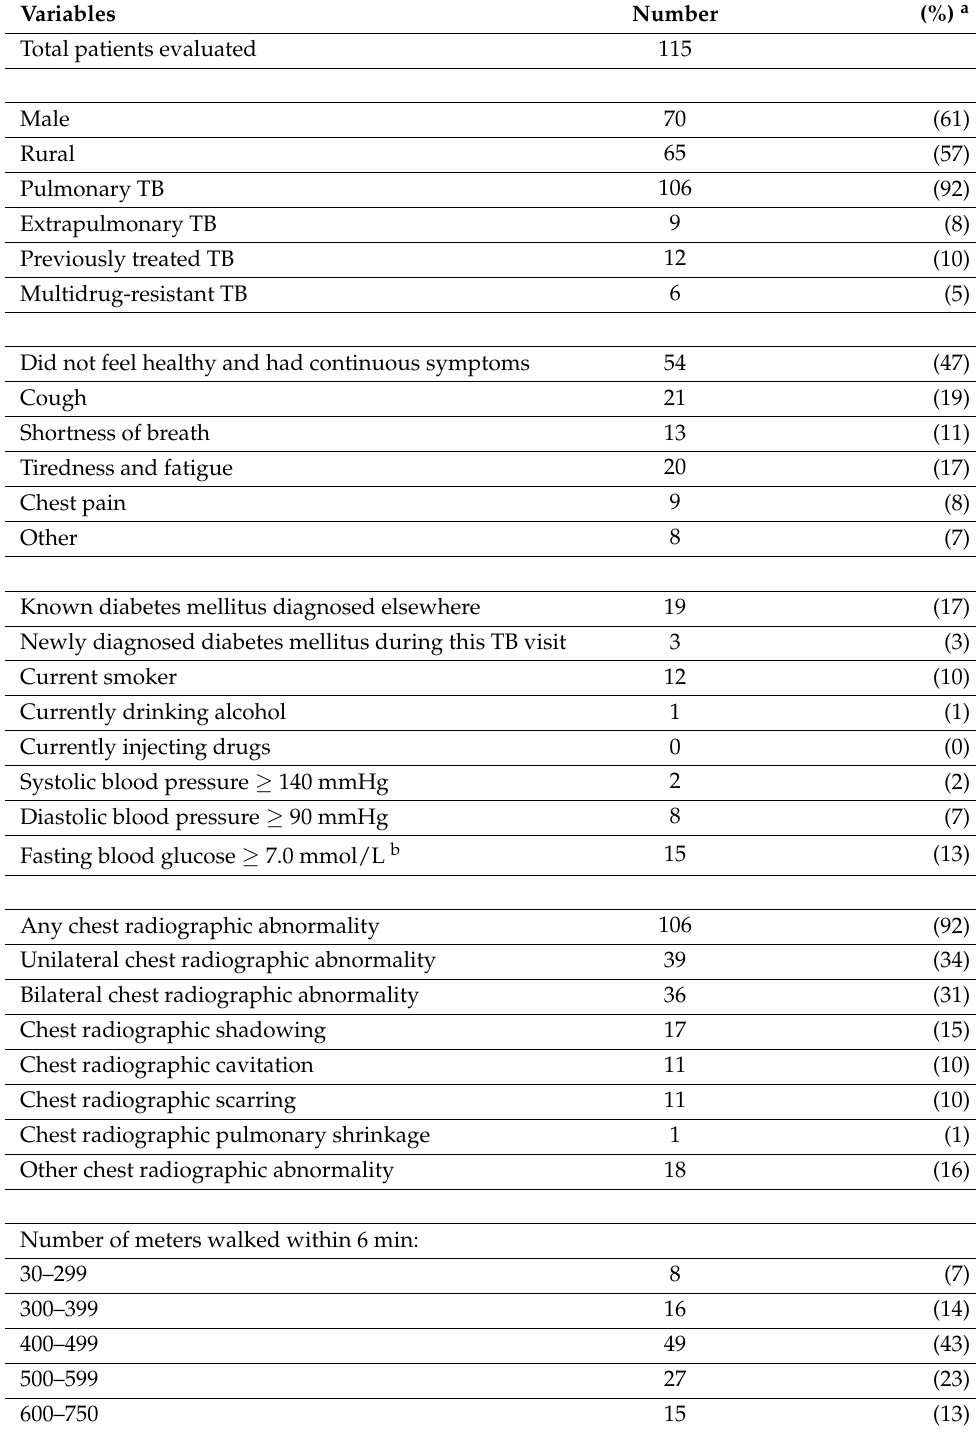
Table 4. Results of post-TB assessment in patients completing anti-TB